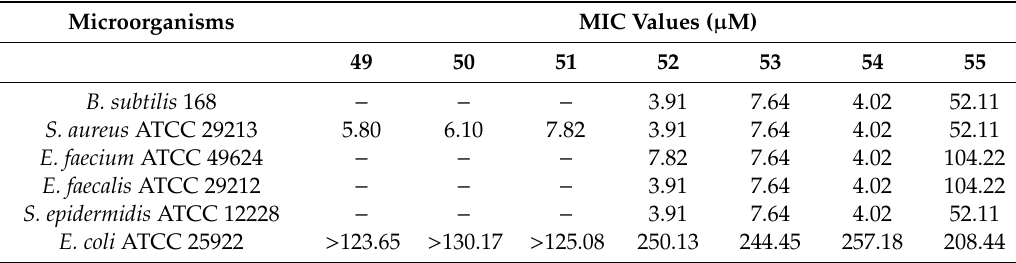
Table 10. MIC values of the pyrimidine analogues on drug-resistant strains.